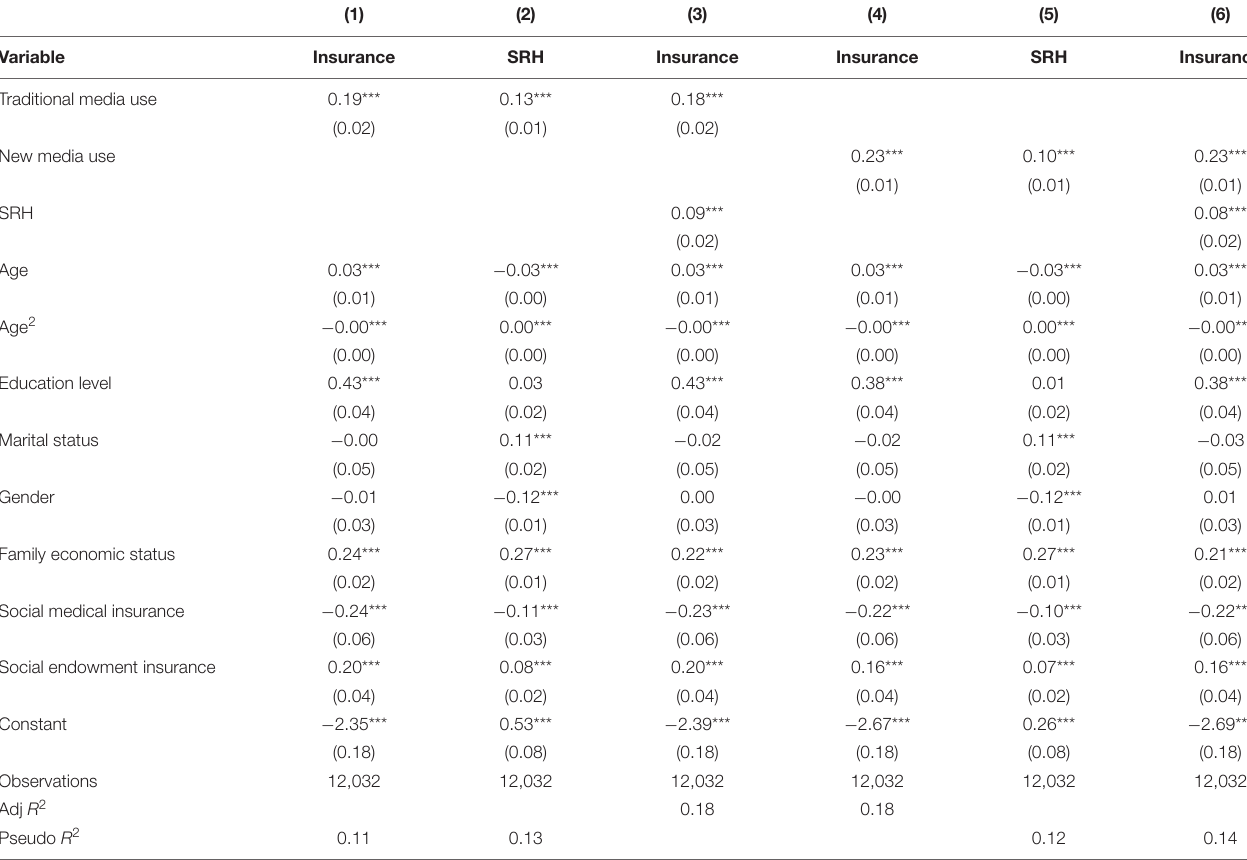
TABLE 4 | Regression results of mediating effect model of media use on the purchase of private medical insurance.